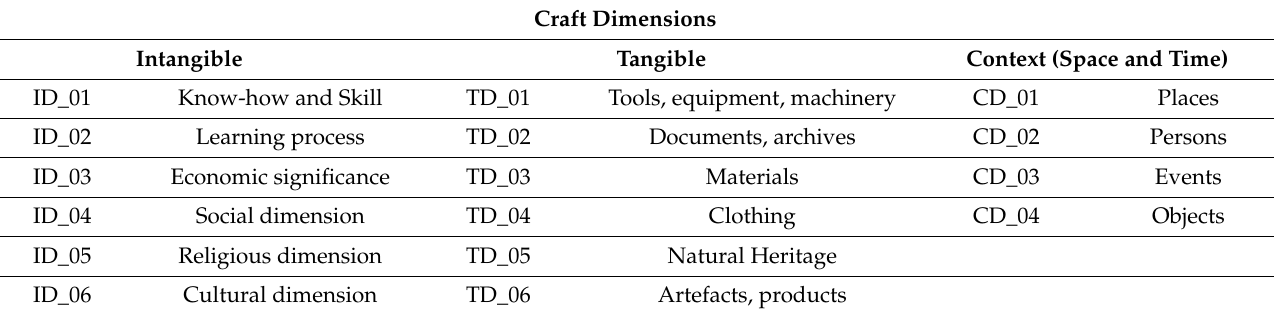
Table 1. Craft dimensions relevant to this research